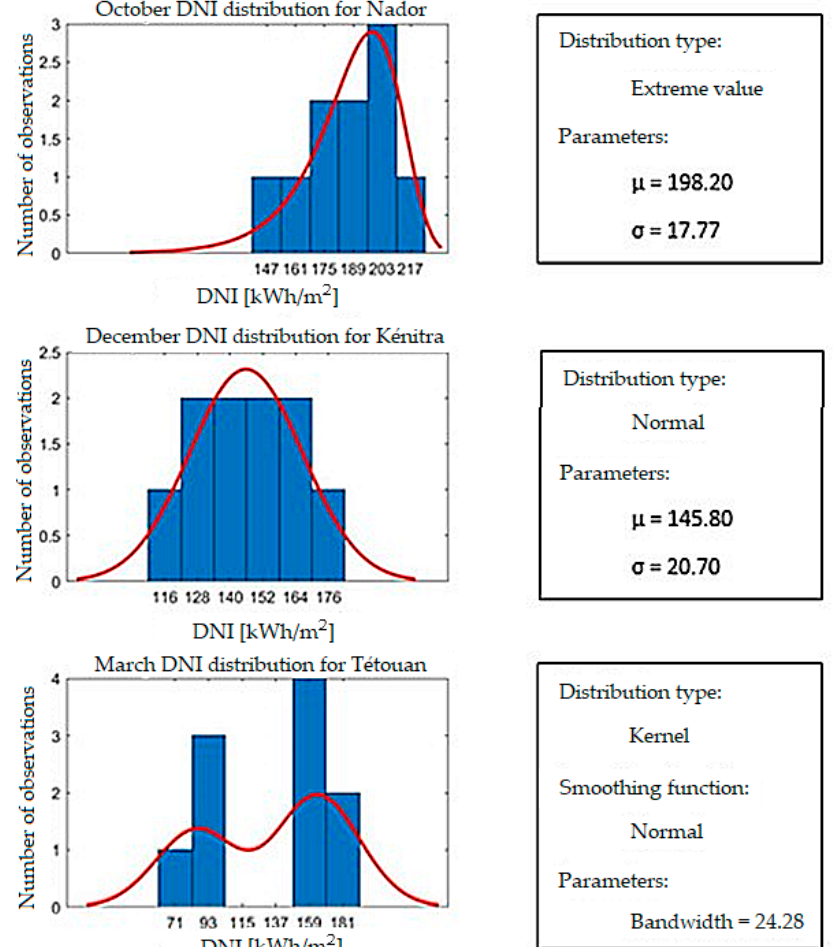
Figure 10. Example of the extreme value, normal and kernel PDFs’ fitting test results for the month of October at Nador, December at Kenitra and March at Tetouan (DNI case). Source: own elaboration.